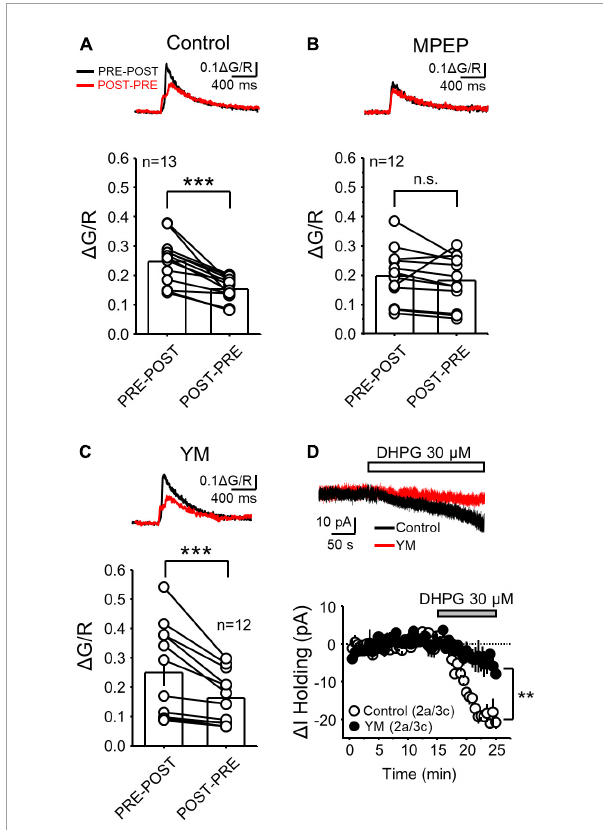
FIGURE2 mGluR5 but not mGluR1 activation was critical for the difference in postsynaptic calcium rise during PRE-POST and POST-PRE at MF-CA3 synapses. (A) Representative traces of PRE-POST and POST-PRE fluorescence profiles in control conditions (top) and summary plots showing the average (cid:49) G/R measured during PRE-POST and POST-PRE patterns (same dataset from Figure 1C ) (bottom). (B,C) Same experimental design as in A but in presence of the mGluR5 antagonist MPEP (4 µ M) (B) and the mGluR1 antagonist YM (1 µ M) (C) . (D) Representative inward current mediated by bath application of the group I mGluR agonist DHPG (30 µ M) in control and during YM co-application (top). Time-course summary plot of the DHPG-mediated change in holding current ( (cid:49) I Holding) recorded from voltage-clamped CA3 pyramidal cells under control conditions and in the presence of YM. Here and in all figures: a, number of animals and c, number of cells. Data are presented as mean ± SEM). ** p < 0.01, *** p < 0.001, n.s. not